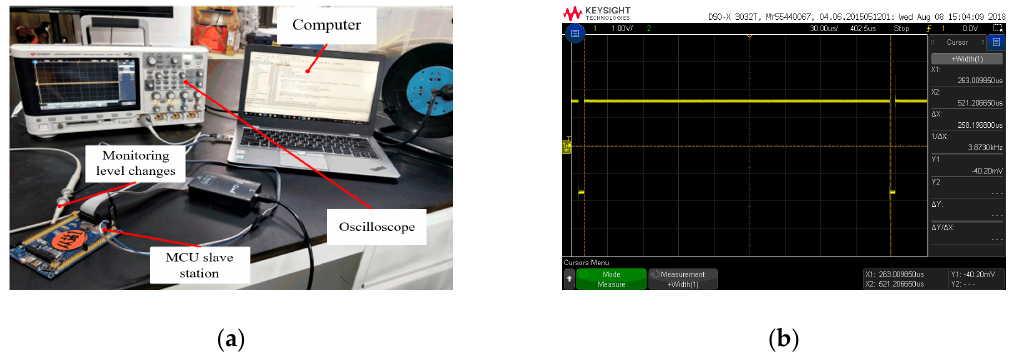
Figure 14. ( a ) The test for the time of synchronous code; ( b ) One of the results.